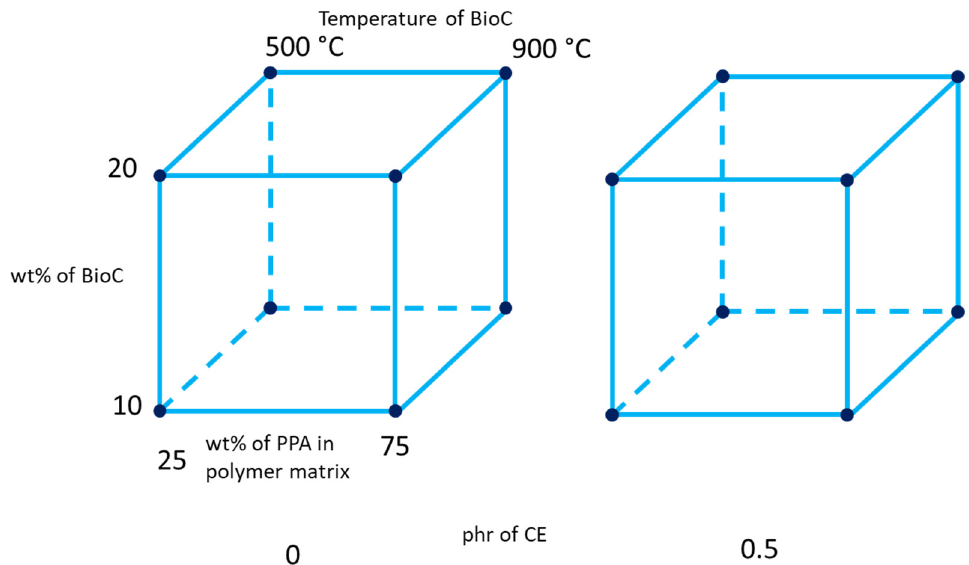
Figure 1. Design of experiment scheme, depicting the four factors: The ratio of PPA in the polymer matrix, wt% content of BioC, the temperature at which the BioC was pyrolyzed, as well as the presence or absence of 0.5 parts per hundred (phr) of CE.